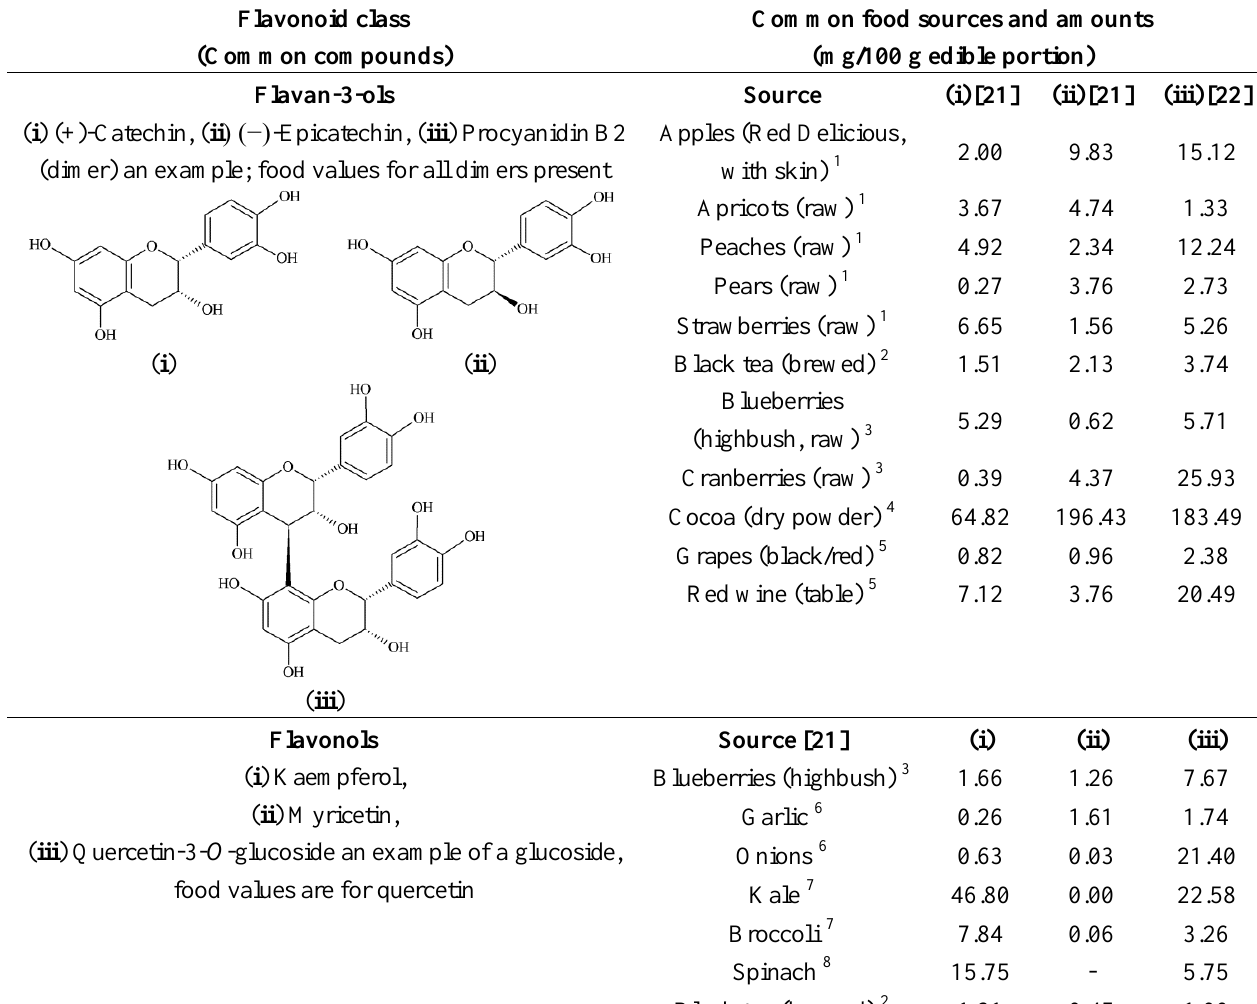
Table 1. Flavonoid classes, common compounds, their dietary sources and amounts